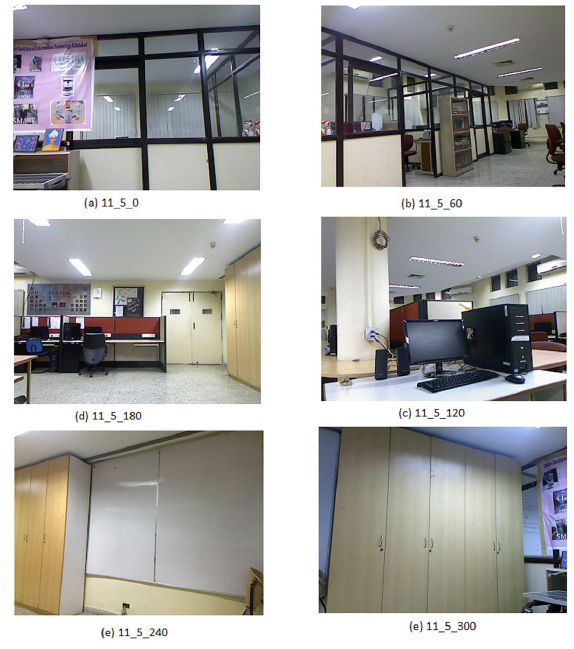
Figure 13: Dataset Images: (a), (b), (c), (d), (e), (f) shows images at 0 degree, 60 degree, 120 degree, 180 degree, 240 degree and 300 degrees respectively at the coordinate (11, 5) from the lab